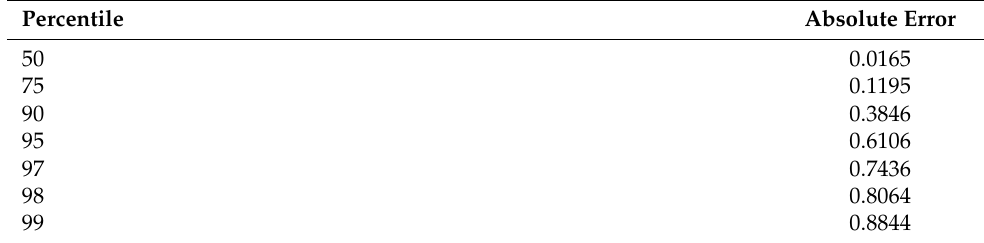
Figure 10. Average GPS testing error for each class. The x -axis shows the average geo-localization margin of error of a given class, and the y -axis indicates how many classes fell within that approximate margin of error. Our GPS-subnet scored a median MOE of ( ± 5) meters. We can see that the GPS-subnet can accurately estimate distance within a reasonably low margin of error, especially considering how far many signs are from the camera in the ARTSv2 dataset. Table 3. A table showing the distribution of prediction errors. Each percentile indicates the percent of absolute errors from the similarity network that are at worst equal to the listed error